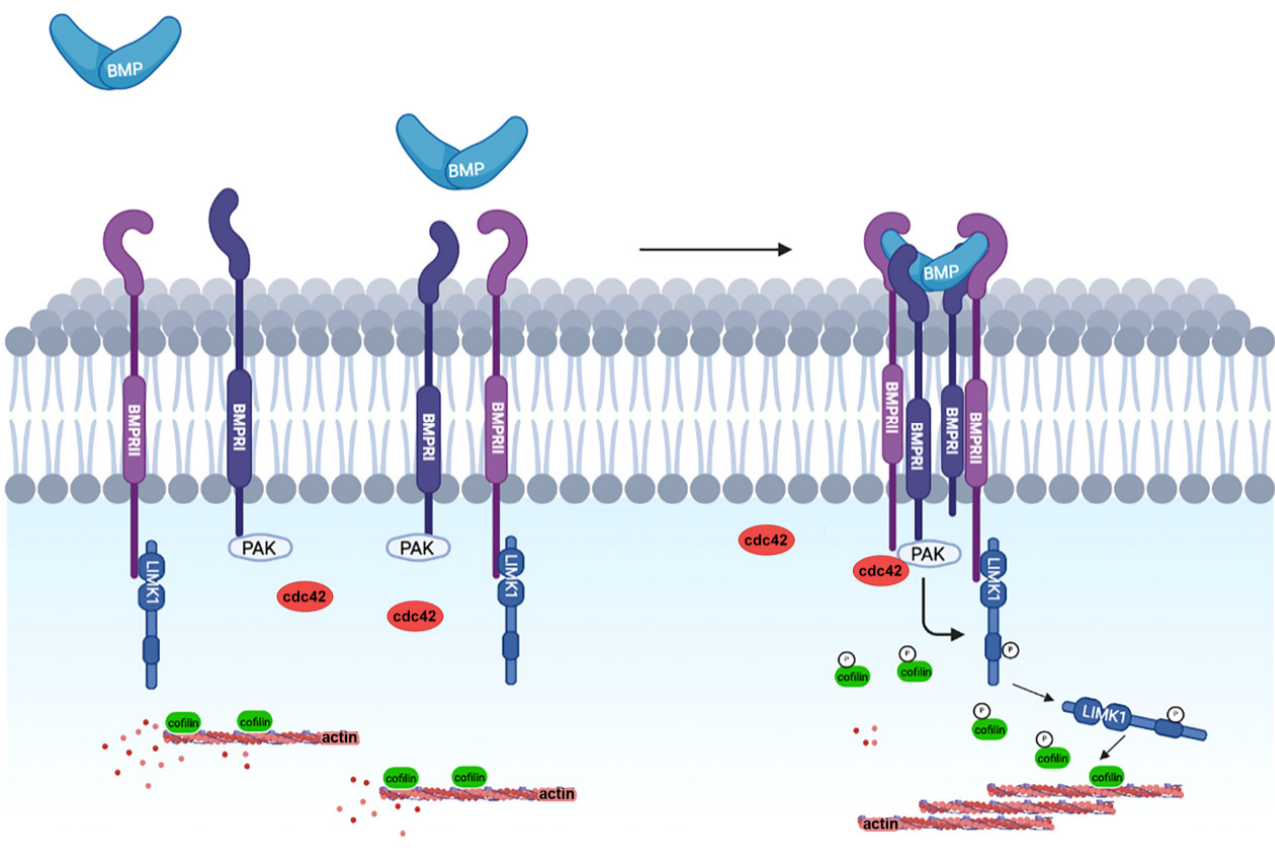
Figure 1. The binding of BMPs leads to the formation of a BMP receptor complex. PAK1, recruited by BMPRI, is thus in close proximity to its target LIMK1, bound to BMPRII. After being activated by cdc42, PAK1 phosphorylates LIMK1, which induces cofilin phosphorylation, thereby inhibiting its activity and thus contributing to the regulation of actin dynamics required for dendrite extension.